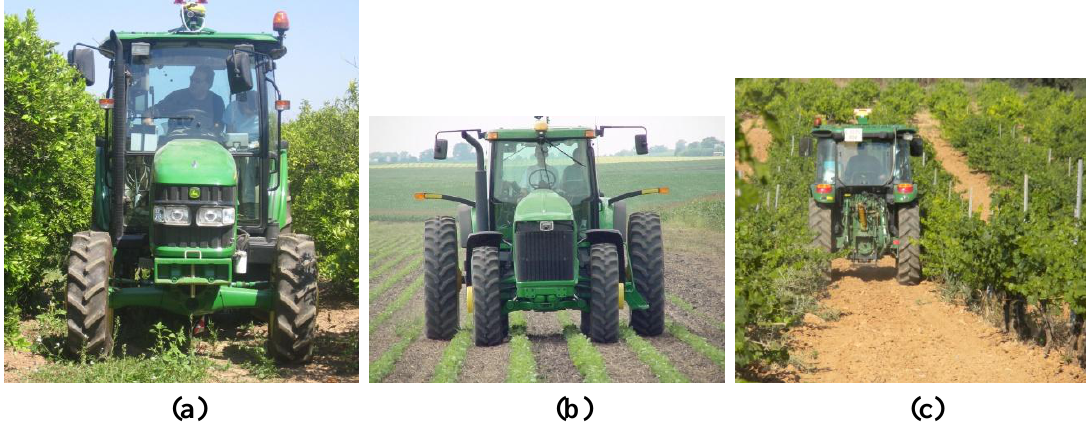
Figure 2. (a) Environment 3: citrus orchard. (b) Environment 4: soybean field. (c) Environment 5: Vineyard